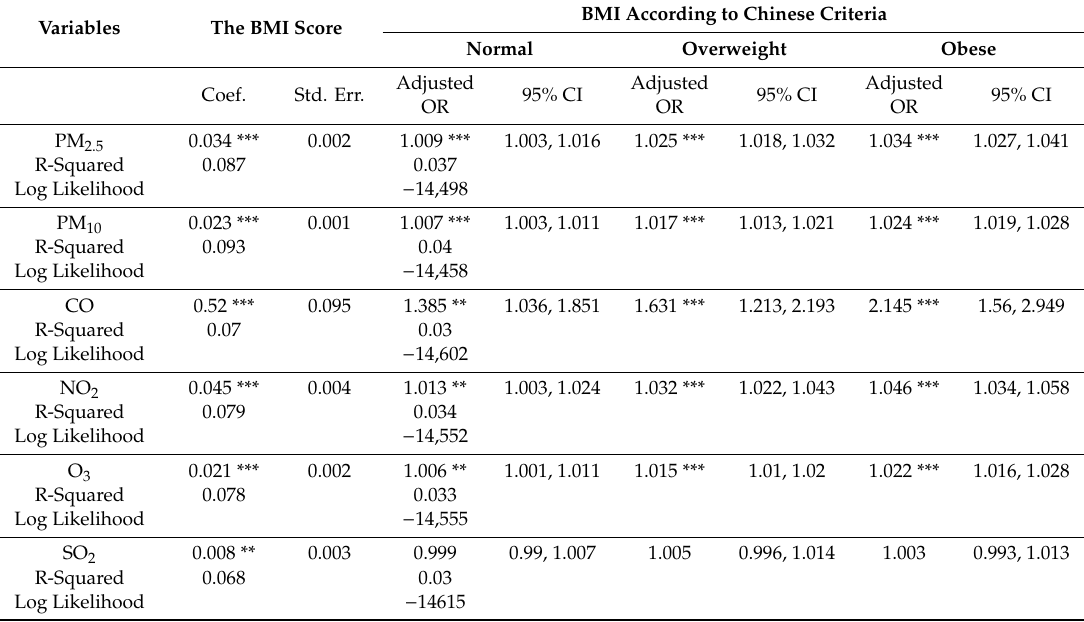
Table 8. E ff ect of other air pollution on Body Mass Index